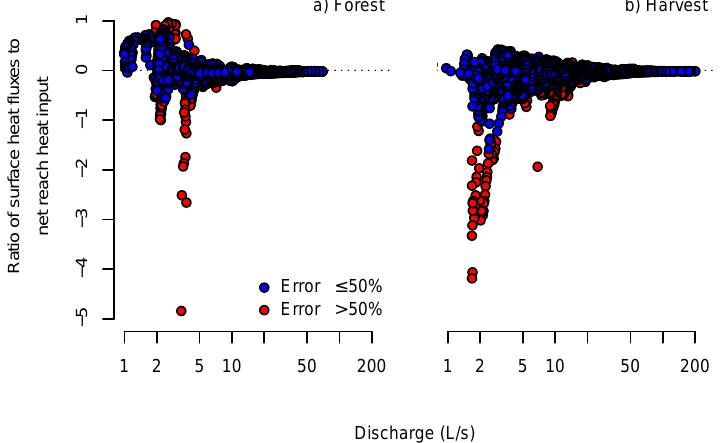
Fig. 5. Ratios of the surface energy fluxes to the net heat inputs for the forest and harvest reaches plotted against hourly discharge at the lower boundary of the respective reaches. Red circles indicate ratios with relative errors less than or equal to 50%, and blue circles indicate ratios with relative errors greater than 50%. Plots include both 2011/2012 and 2012/2013 data. Positive ratios indicate that the surface fluxes are adding heat to the reach and negative ratios indicate they are removing heat from the reach. Note the x axis scale is